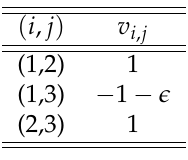
Figure 7. Graph G and valuations v i , j